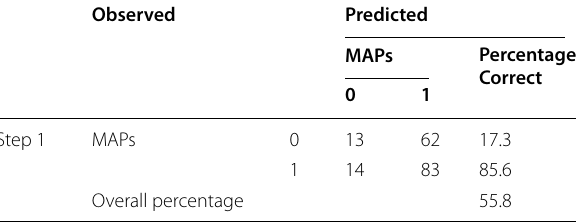
Table O: Classification table for aggressive culture